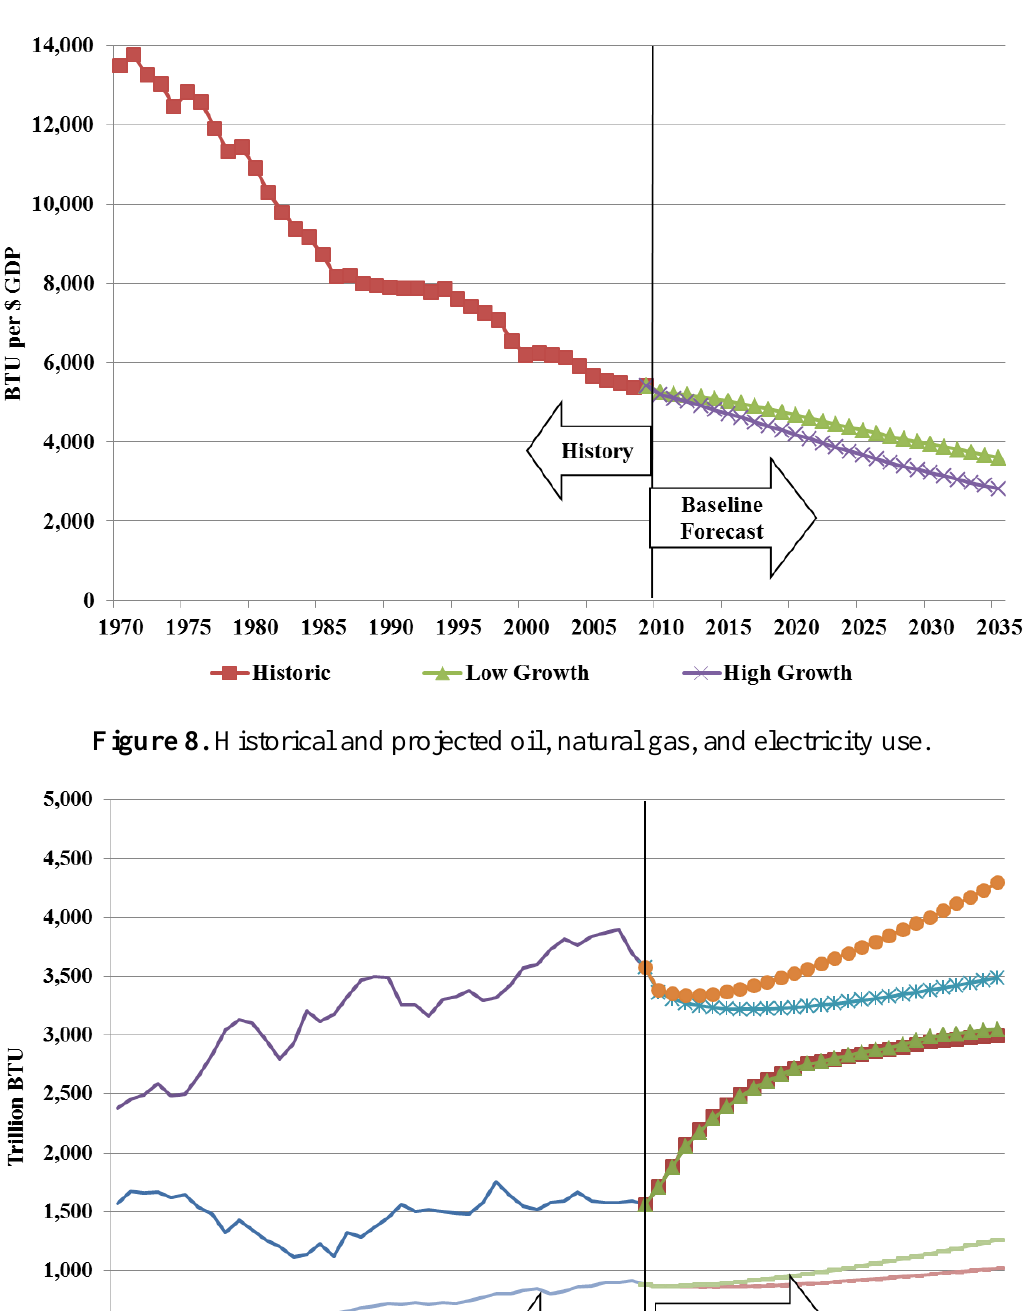
Figure 7. Historical and projected energy intensity of use.